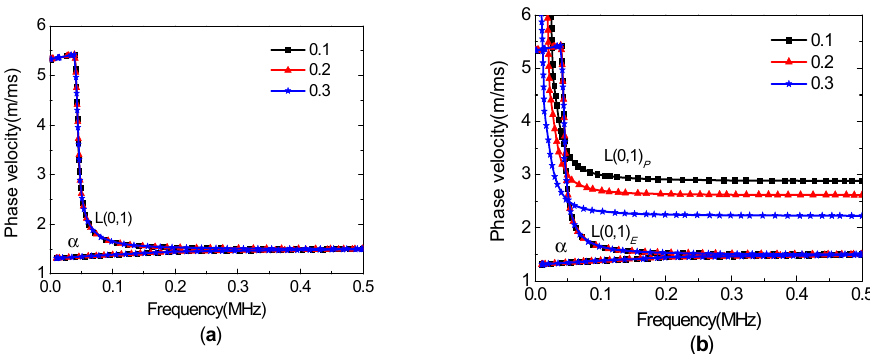
Figure 4. Dispersion curves of guided waves in a water-filled pipe embedded in ( a ) infinite porous medium and ( b ) finite porous medium. The thickness of the finite porous medium is d = 0.05 m. Black, red, and blue lines represent the porosity β = 0.1, 0.2, and 0.3,